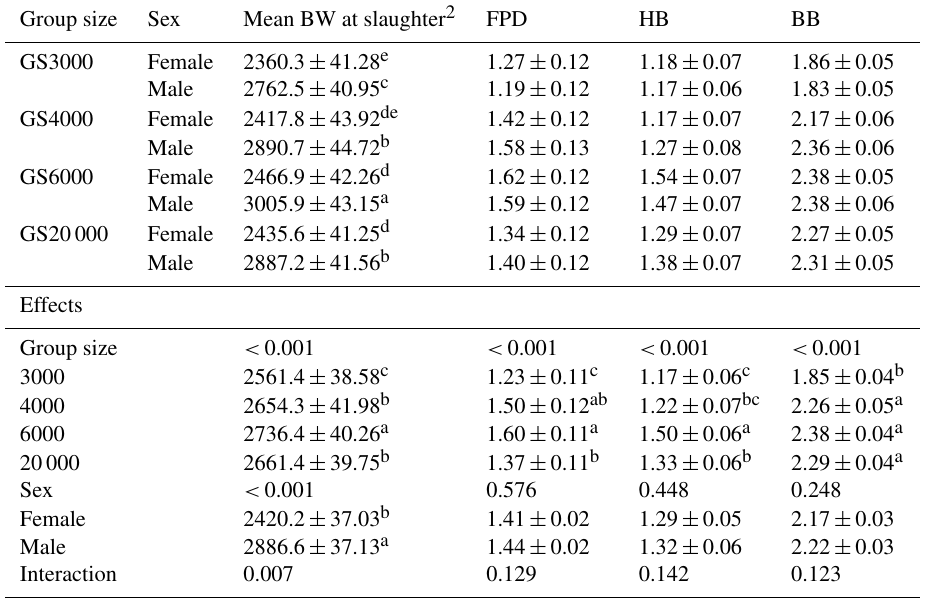
Table 4. Least square mean and standard error ( ± SE) of body weight (g), foot pad dermatitis, hock burn, and breast burn levels in slaughter age broilers reared in varying group sizes 1